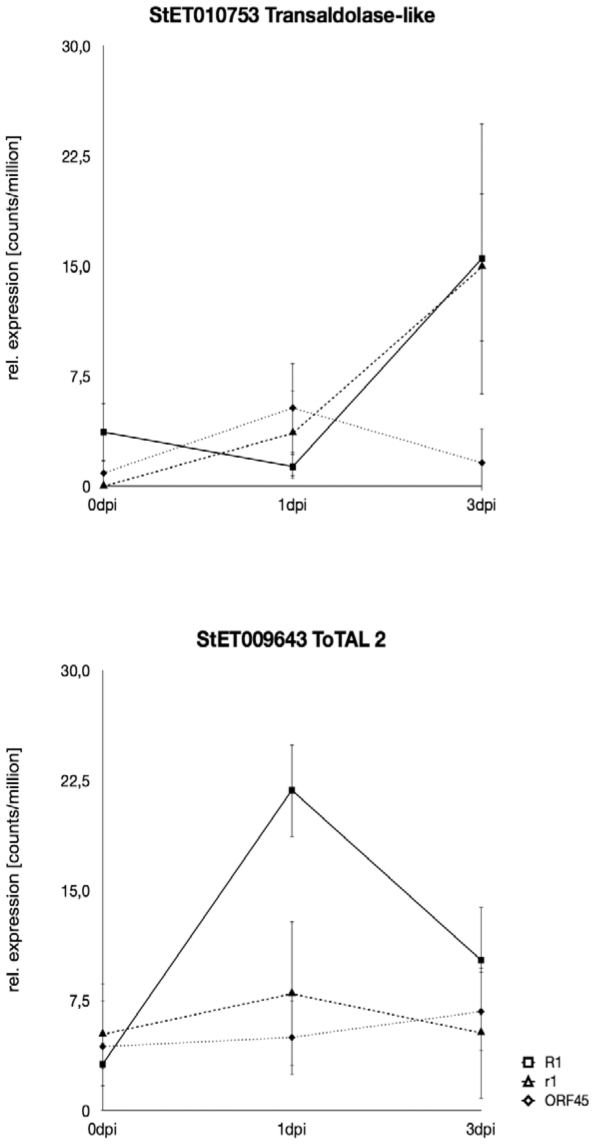
Expression patterns of tags StET010753 and StET009643 matching the tomato transaldolase isoforms ToTAL1 (PotTAL1) and ToTAL2, respectively.Tag StET10753 is weakly up regulated in the R1 and r1 plants but not in the ORF45 plants at three days post inoculation. Tag StET009643 shows clear up regulation only in the R1 plants one day after inoculation. Transcript levels are shown as mean tag counts/million of six (R1 and r1 plants), three (ORF45 plants at 0 dpi and 2 dpi) and two (ORF45 plants at 3 dpi) independent samples. Bars indicate the standard deviation according to the Poisson distribution.